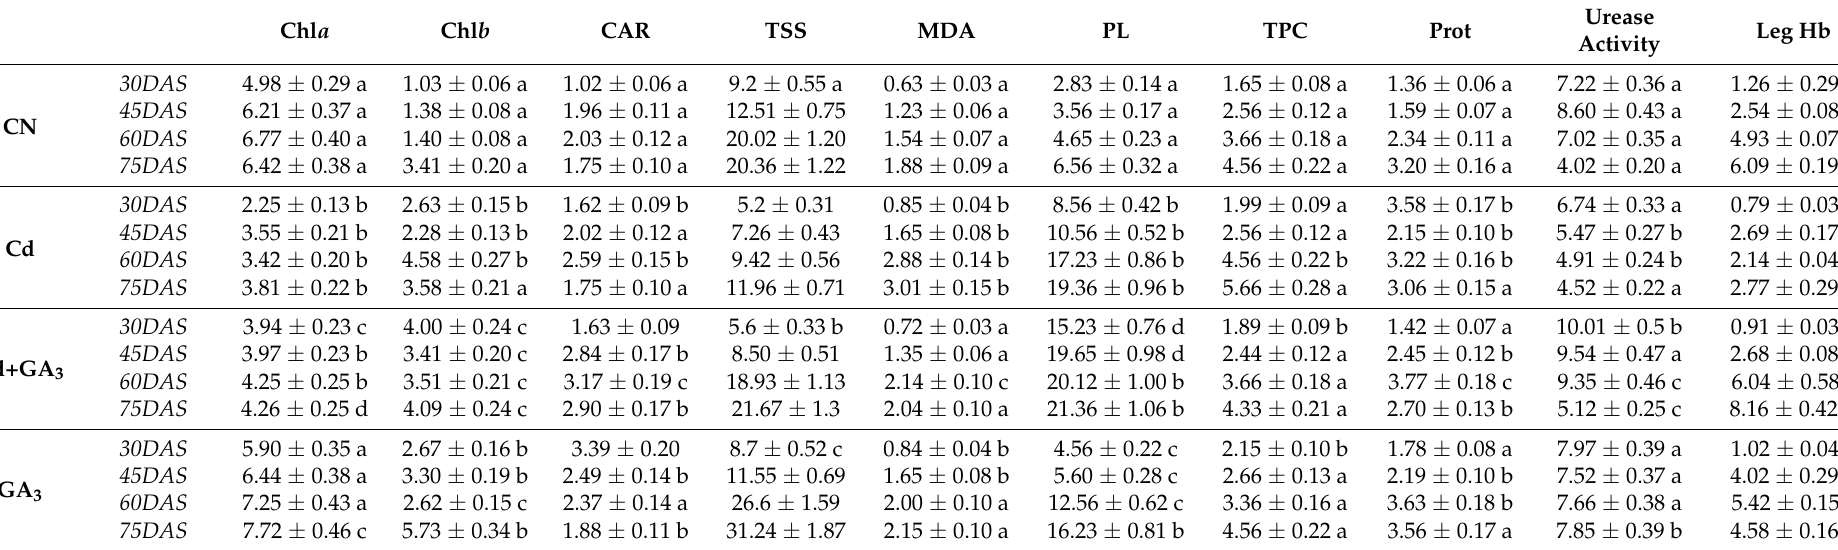
Table 1. Effect of cadmium (Cd) stress with or without gibberellins (GA 3 ) on the physiological attributes of Vigna radiata L. on chlorophyll a (Chl a), chlorophyll b (Chl b), carotenoids (CAR), total soluble sugars (TSS) in mg g − 1 fresh weight, malondialdehyde (MDA, µ mol g − 1 fresh weight), proline (PL), total phenol content (TPC), protein (Prot) content in mg g − 1 fresh weight, urease activity (UA, µ g NH 3 g − 1 15 min − 1 ) and nodule leg hemoglobin content (Leg Hb, mg g − 1 fresh weight) in leaf tissues subjected to control (CN), cadmium stress